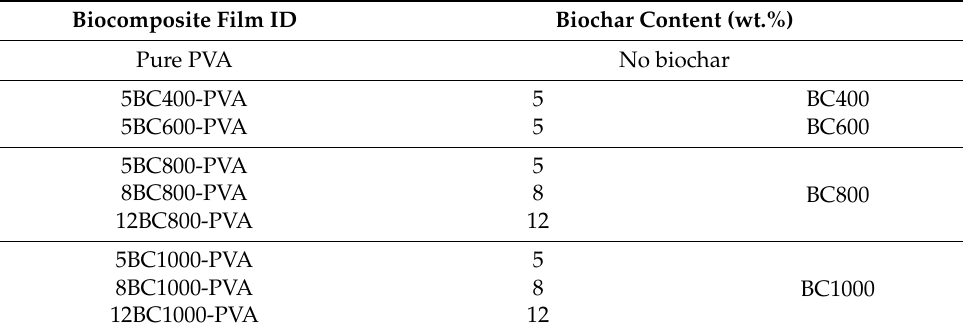
Table 1. Biocomposite film samples with identification code and biochar